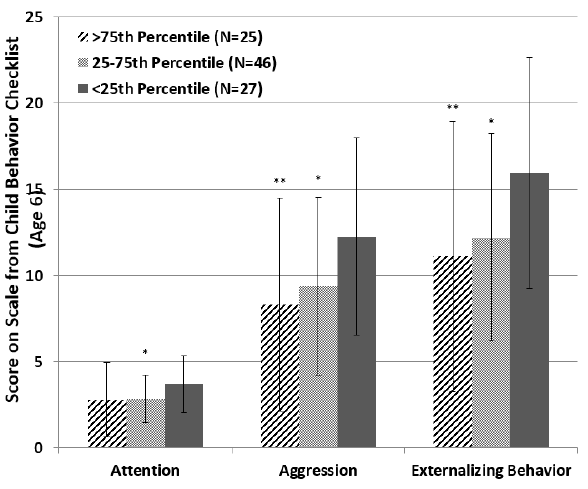
Figure 1. Score for externalizing behaviors at age 6 among children who tested for hemoglobin levels at age 4. * Trending significant (0.05 < p ≤ 0.1) differences in behavior score when compared with the <25th percentile group. ** Significant (at α = 0.05) differences in behavior score when compared with the <25th percentile group.